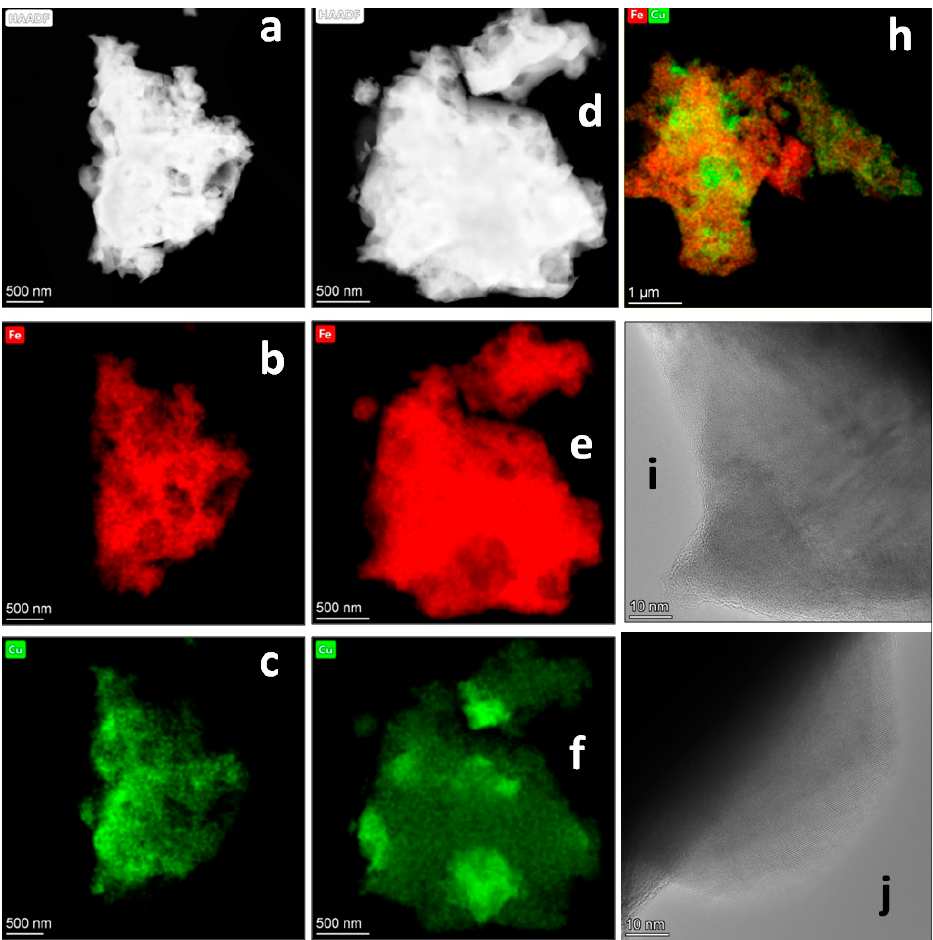
Figure 9. For an active CuFe-1 sample before catalytic experiments, ( a, d ) dark-field images with ( b–f ) the corresponding elemental mappings, ( h ) elemental mappings for another particle, and ( i, j ) HRTEM images.